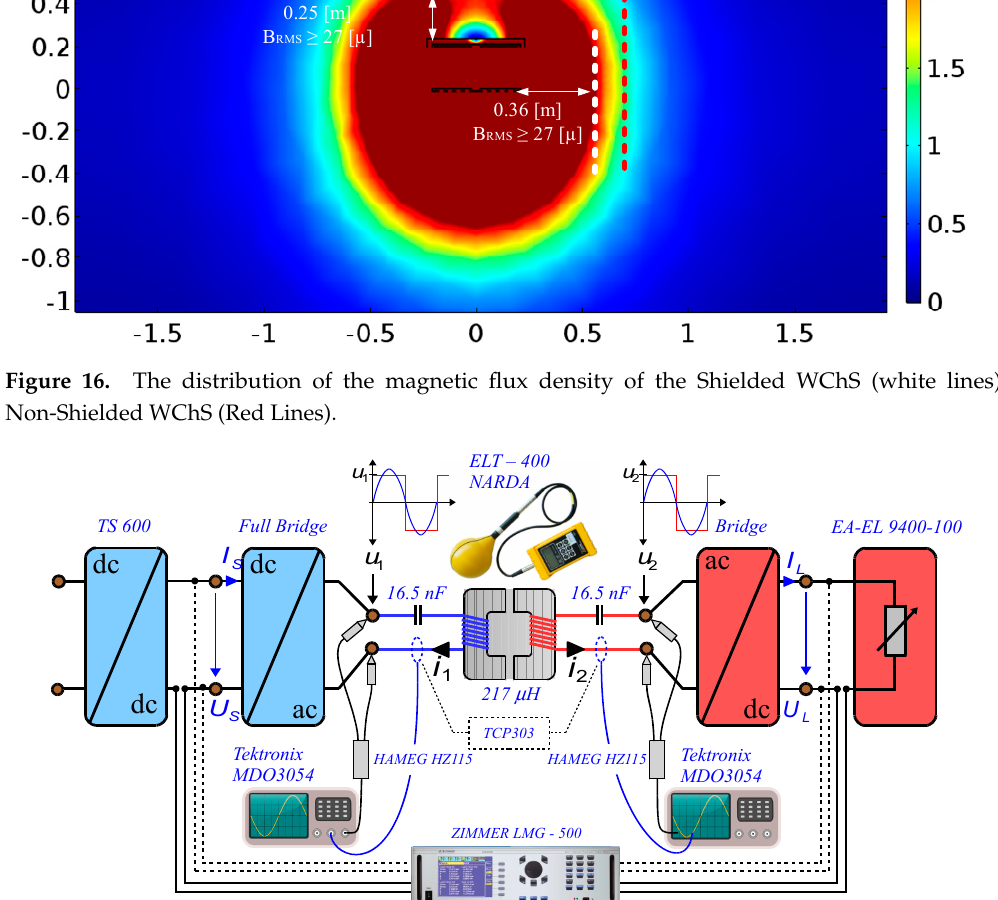
Figure 16. The distribution of the magnetic flux density of the Shielded WChS (white lines), Non- Shielded WChS (Red Lines).